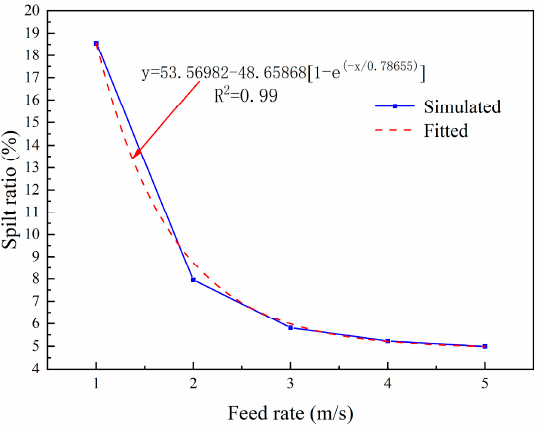
Figure 14. Split ratio curves under different feed rates at inlet .